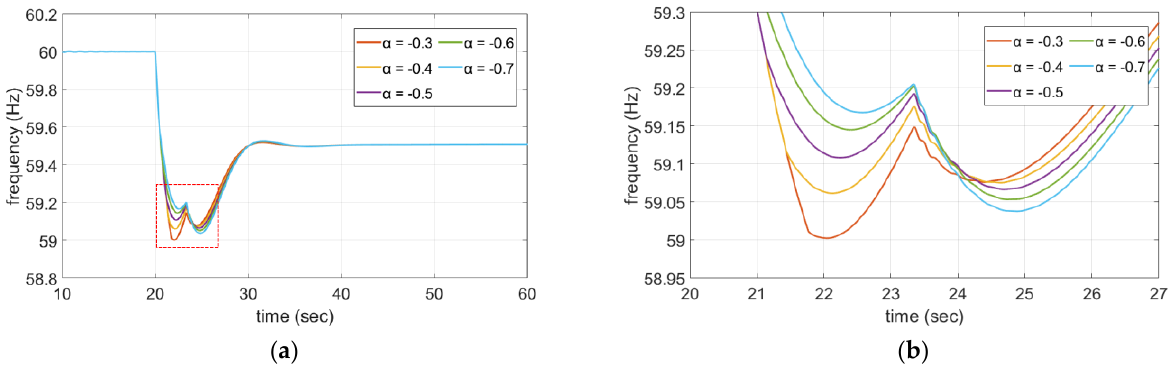
Figure 9. Proposed NCCS results according to constant α change: ( a ) system frequency; ( b ) system frequency (enlarged view). Figure 10. FFR with only the PMSG control: ( a ) the RoCoF; ( b ) the RoCoF (enlarged view).